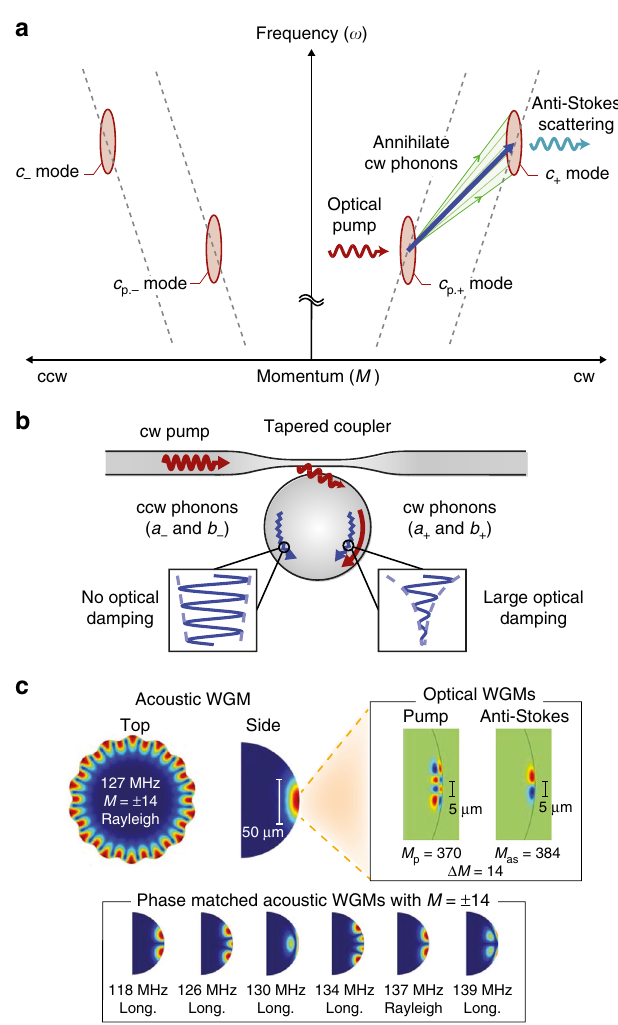
Fig. 1 Chiral cooling and modal relationships in a whispering-gallery resonator. a Con fi guration of the two requisite optical whispering-gallery modes (WGMs) with cw (+) and ccw ( − ) degeneracy is illustrated in ( ω , M ) space. Integer M describes the azimuthal momentum of WGMs. Anti-Stokes Brillouin scattering from cw pumping of the lower mode annihilates only cw phonons of all phase-matched dispersion relations, while ccw phonons remain nominally unaffected, thus breaking parity symmetry in the system. The optical modes are illustrated elongated in ω - space due to the extremely large phase velocity of photons in comparison to phonons. b Directional optical interface to the resonator modes is achieved via tapered optical fi ber. Unidirectional optical pumping results in dramatic chiral damping of the phonons. a ± and b ± phonon modes are described in Fig. 3. c Our experiment is performed using a high- Q M = ± 14 acoustic WGM ( a ± ) using two optical WGMs having the same momentum separation. There also exist an extended group of acoustic bulk modes having the same M (representative members illustrated) that are also phase matched but are not observable above the noise fl oor due to high mechanical damping and poorer frequency matching. These are considered in our model collectively as a quasi-mode ( b ± beat spectrum generated between the scattered light and the corresponding source in either direction provides a direct mea- sure of the phonon mode spectrum (Supplementary Note 4), with sample measurements shown in Fig. 2c. In the experiment, the optical pump and probe sources are both derived from the same laser and are thus always at identical frequencies. Throughout the